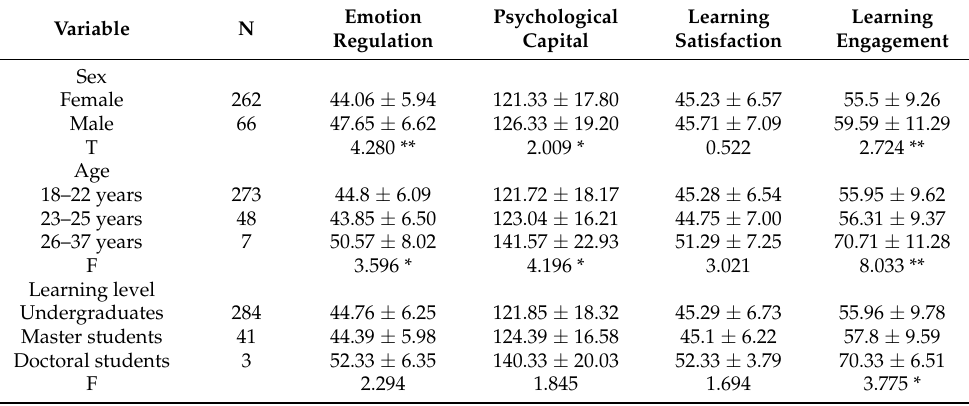
Table 4. Differences between student groups with different demographic characteristics in the total mean and standard deviation scores of emotion regulation, psychological capital, learning satisfaction, and learning engagement.